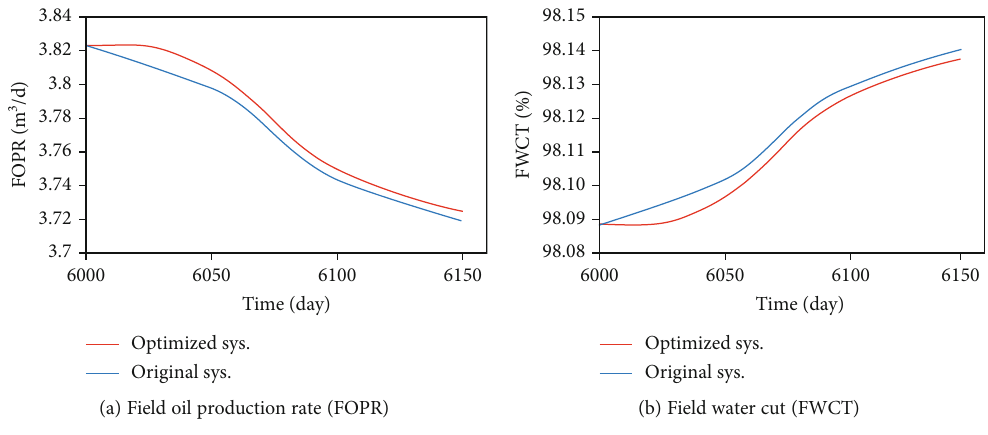
Figure 9: The comparison of optimized and original production